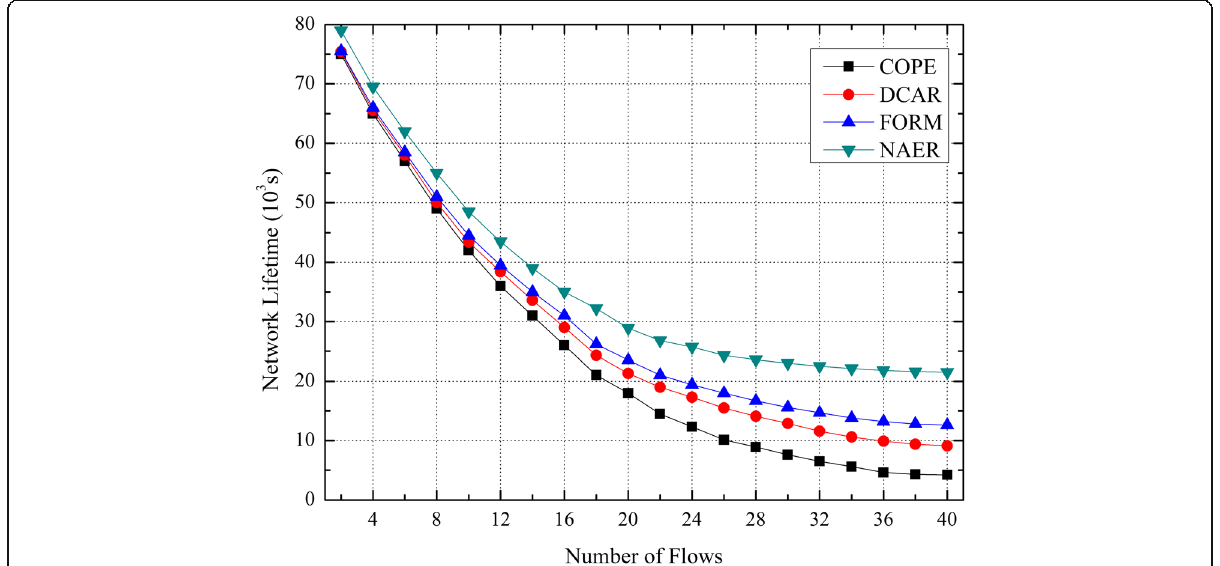
Fig. 22 Network lifetime under different number of flows in grid network. Figure 22 shows the network lifetime comparison of COPE, DCAR, FORM, and NAER under different number of flows in grid network